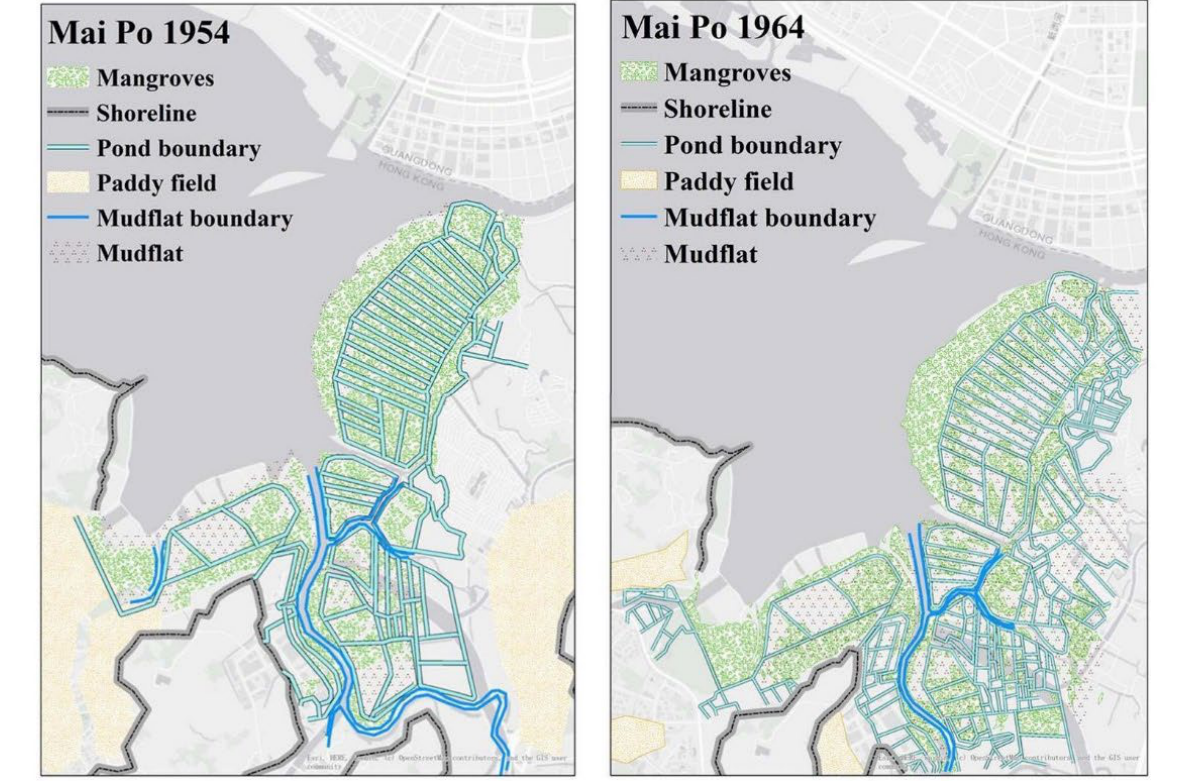
Figure 4. Mapping results are based on historical aerial photos from 1924 to 1964. The scales are: 1:14,332 (1924); 1:12,000 (1945); 1:25,029 (1954); and 1:25,029 (1964). Relevant locations are indicated: Deep Bay (DB), Mai Po (MP), Shan Pui River (SPR), Nam Sang Wai (NSW), and Shenzhen (SZ) in the top right panel for reference.